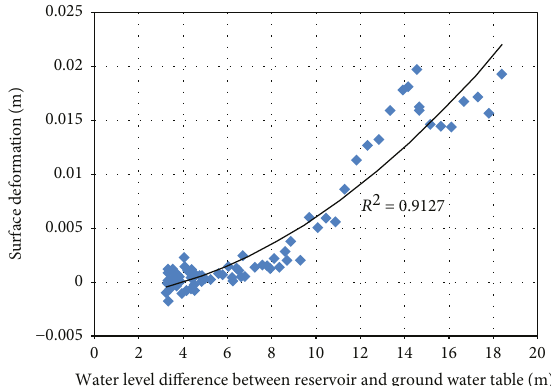
Water level difference between reservoir and ground water table Figure 14: Correlation between the water level di ff erence inside and outside the slope versus daily slope deformation in ZK-5.